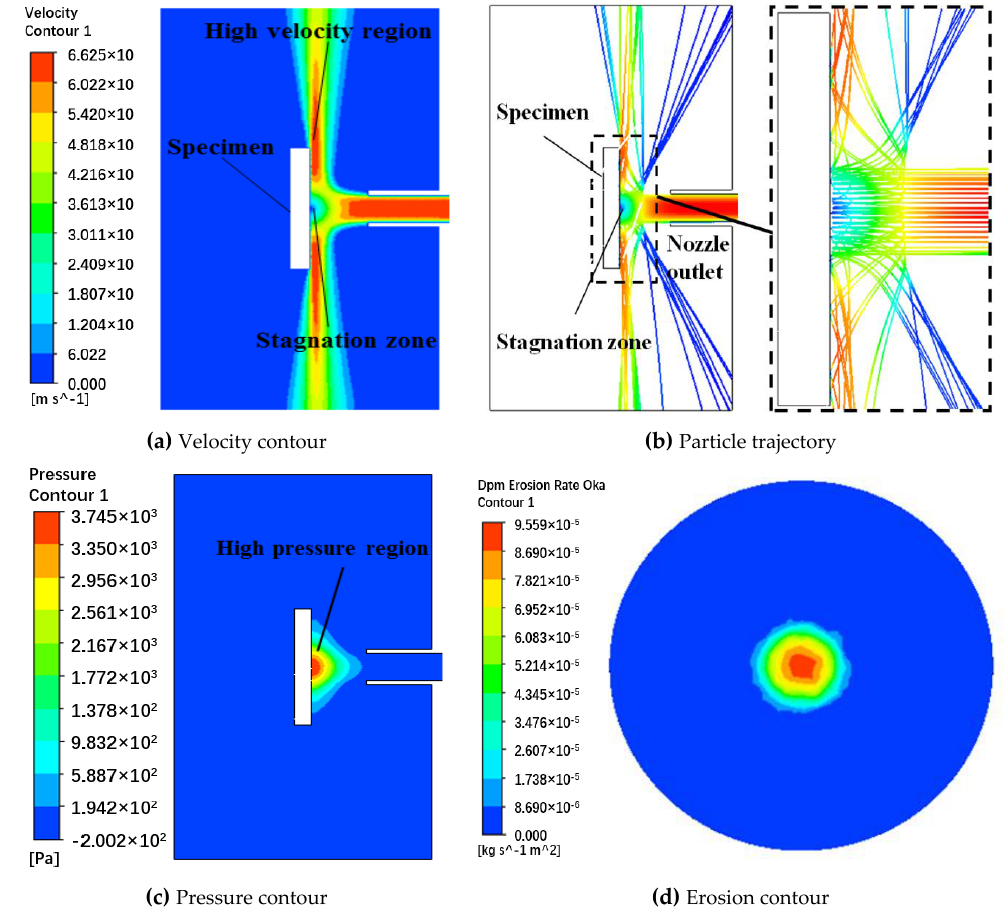
Figure 8. CFD analysis results. ( a ) Particle velocity contour. ( b ) Particle trajectory. ( c ) Specimen pressure contour. ( d ) Specimen erosion contour.